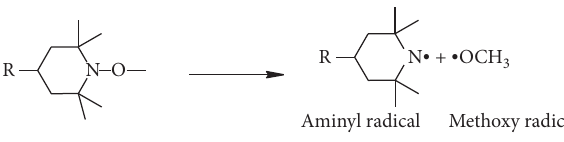
Scheme 4: Free radical formation from